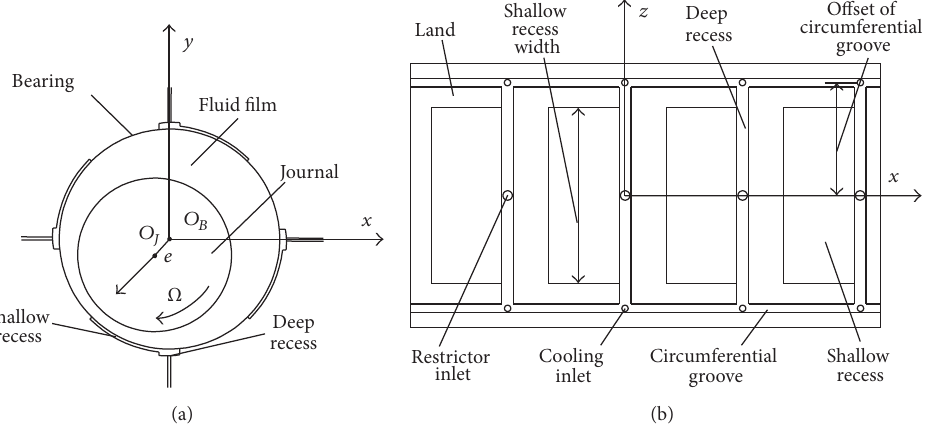
Figure 1: Structure of the water-lubricated hybrid bearing.